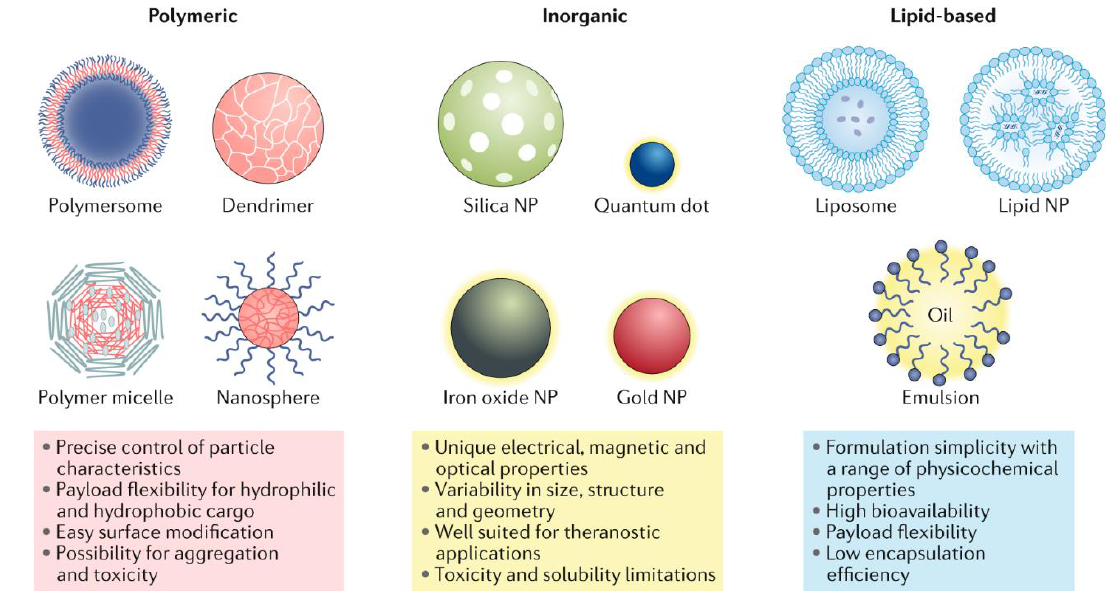
Figure 1. Each class of nanoparticle (NP) features multiple subclasses, with some of the most common highlighted here. Each class has numerous broad advantages and disadvantages regarding cargo, delivery and patient response. Reprints from: Mitchell, M.J., Billingsley, M.M., Haley, R.M. et al. Engineering precision nanoparticles for drug delivery. Nat. Rev. Drug Discov. 20 , 101–124 (2021) [4].